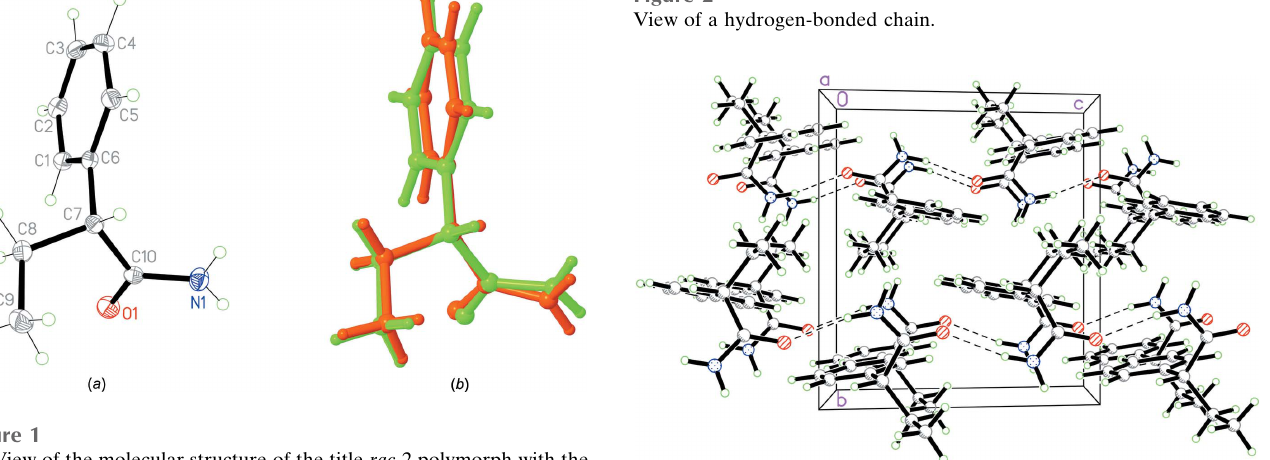
Figure 3 The crystal packing of the rac -2 polymorph.